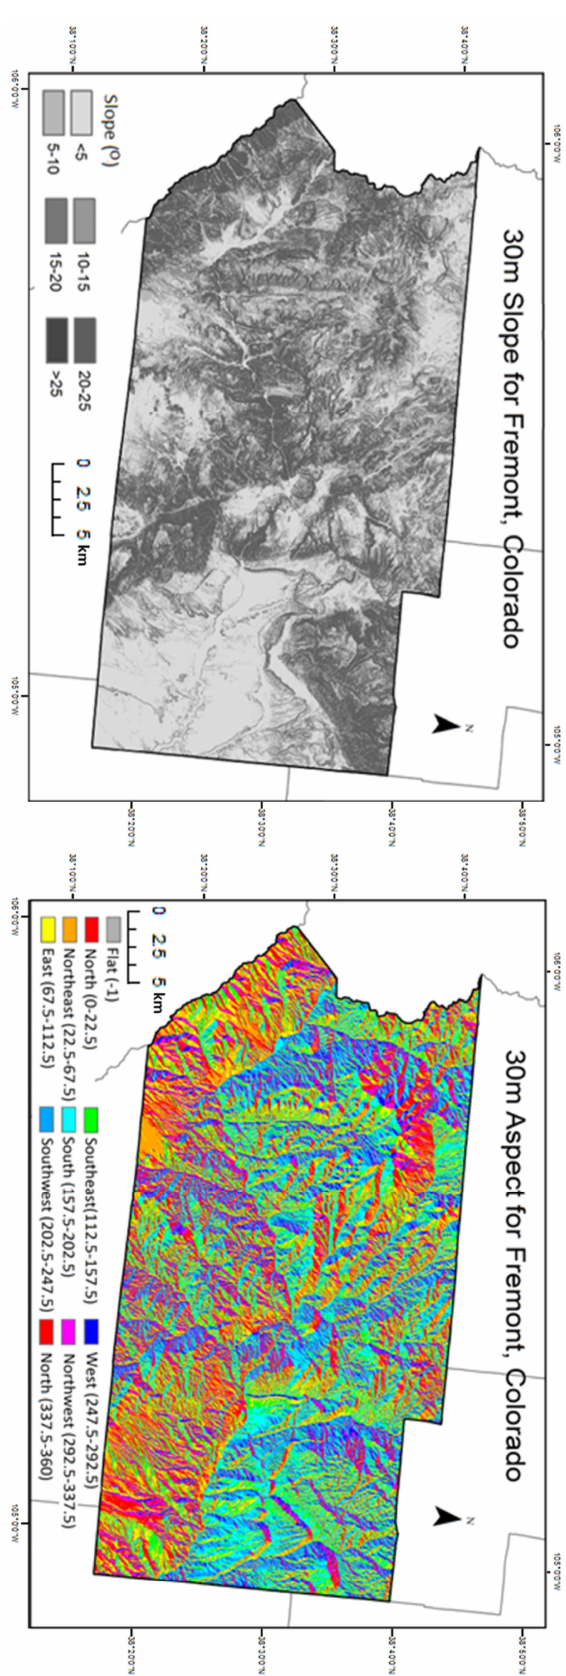
Figure 4. Slope and aspect image for Fremont County, Colorado.